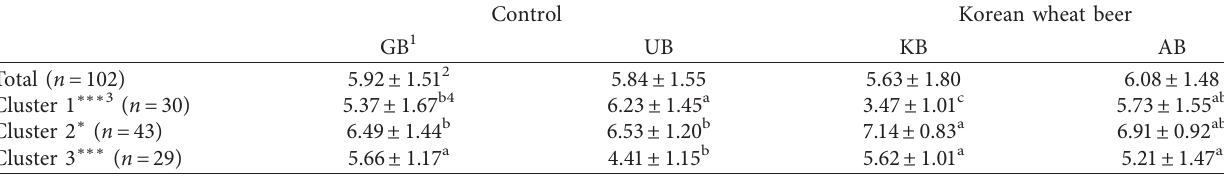
Table 4: Overall acceptance for four beer samples depending on preference segments by agglomerative hierarchical cluster analysis